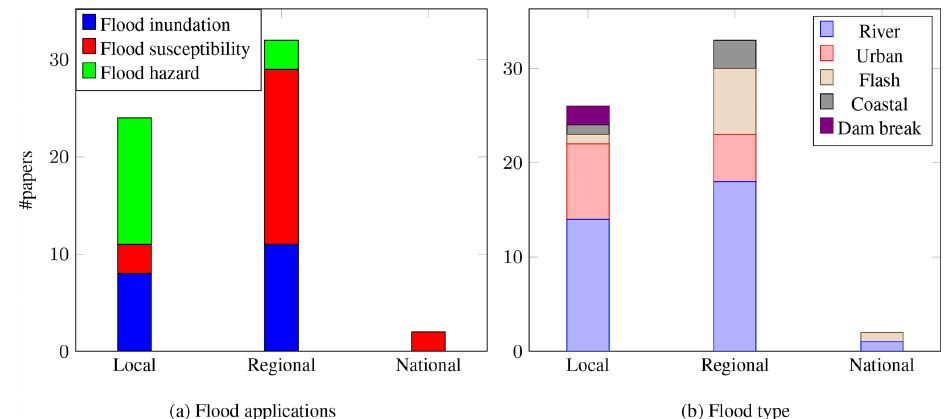
Figure 6. Distribution of the spatial scale per (a) flood application and (b) type of flood in the reviewed papers. Local and regional scales are the most